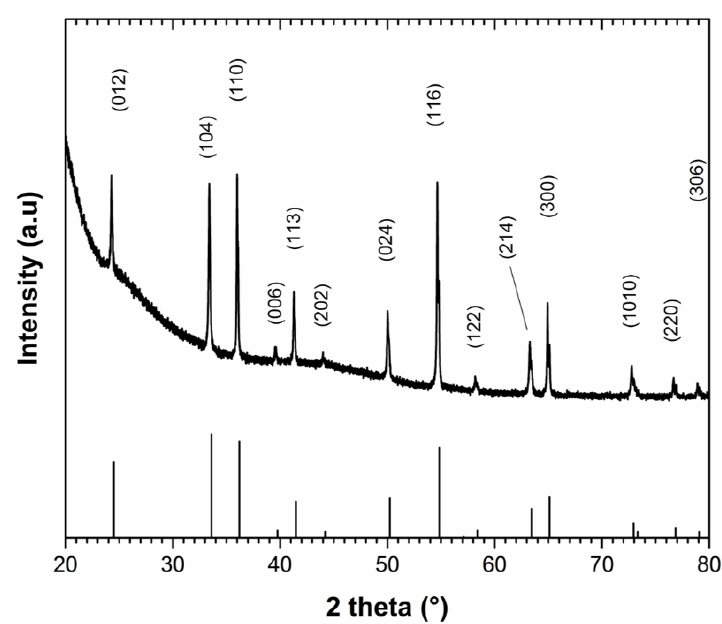
Figure 1. XRD pattern of the as-templated Cr 2 O 3 material (top pattern). For comparative purposes, the diffraction profile of the Cr 2 O 3 Eskolaite phase is shown (bottom pattern) (JCPDS No. 038-1479).